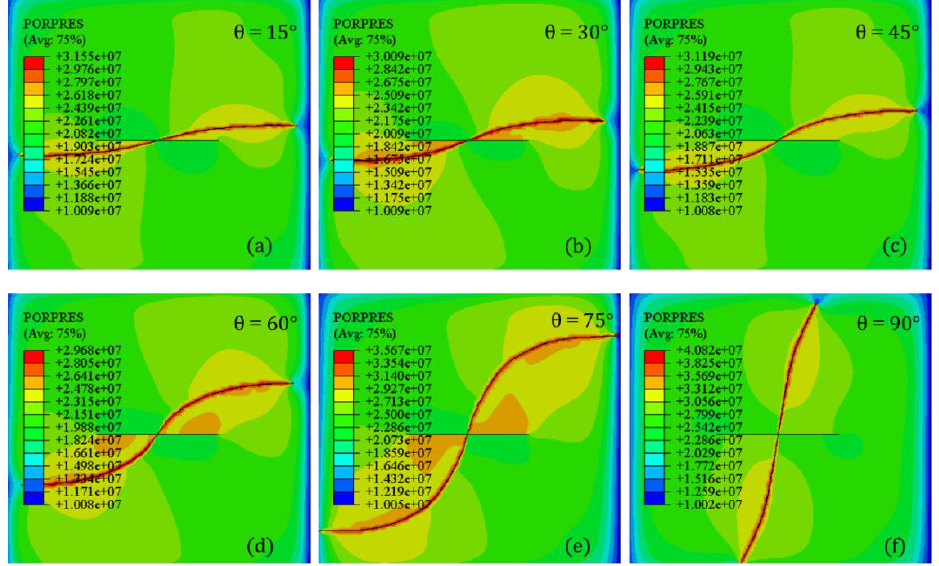
Figure 7. Reorientation behavior of refracturing fractures with different perforation azimuth angle (PORPRES present the pore-pressure with enrichments: unit is Pa).